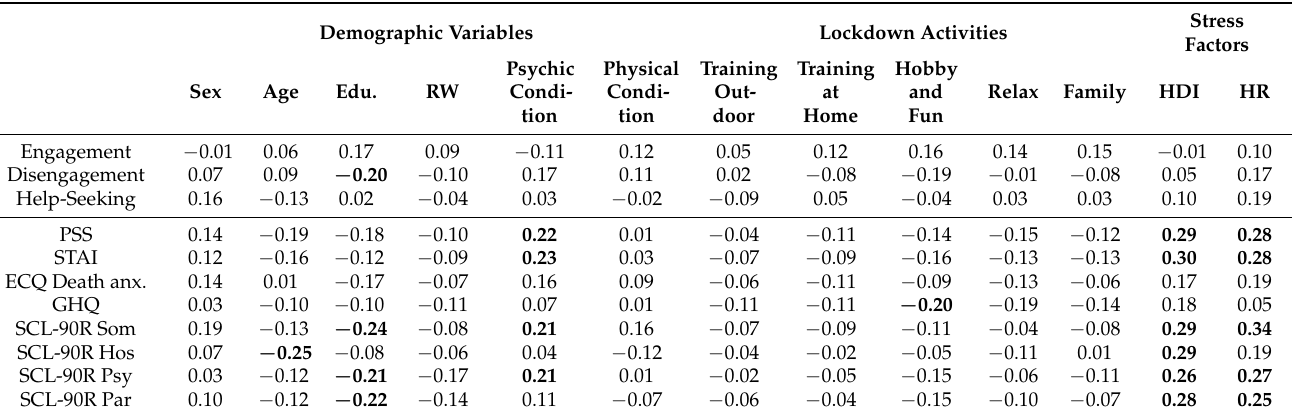
Table 4. Bivariate correlation coefficients between demographic variables, lockdown activities, stress factors, and coping styles.